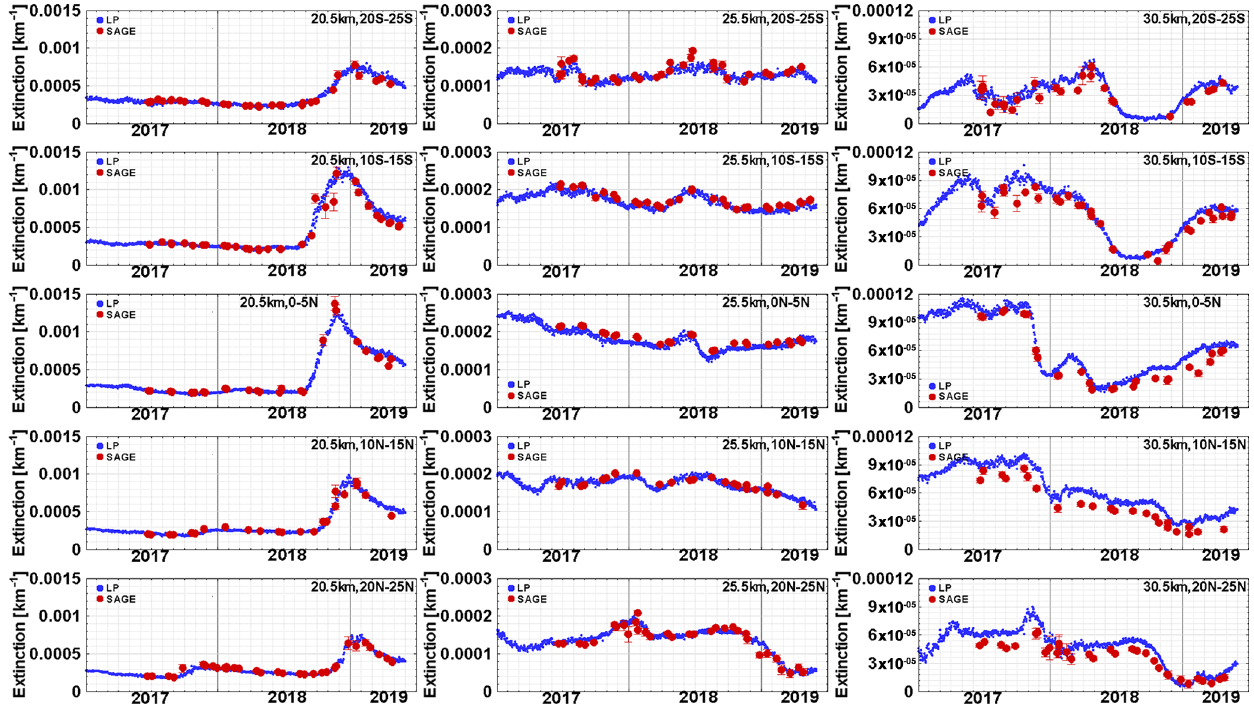
Figure 4. Comparison of the daily zonal mean time series of LP V1.5 (blue) and SAGE III/ISS V5.1 (red) extinction values at 675nm for an altitude of 20.5km (left column), 25.5km (middle column), and 30.5km (right column) for 5 ◦ latitude bands in the tropics (20–25 ◦ S, √ N . the SAGE measurements indicate the standard error of the mean, σ/